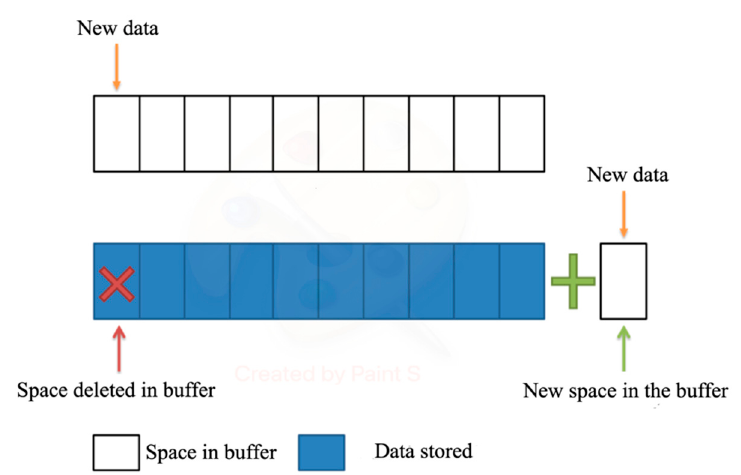
Figure 5. The algorithm in the car ′ s black box system.